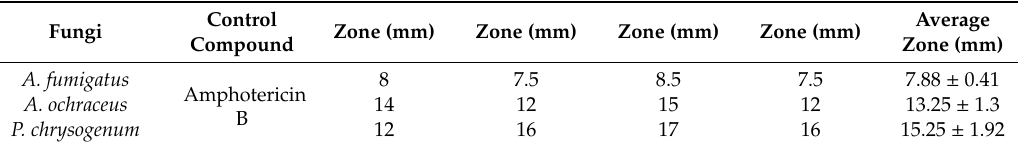
Table 4. Minimum inhibition zones generated by the control (reference compound), AmB, for various strains of